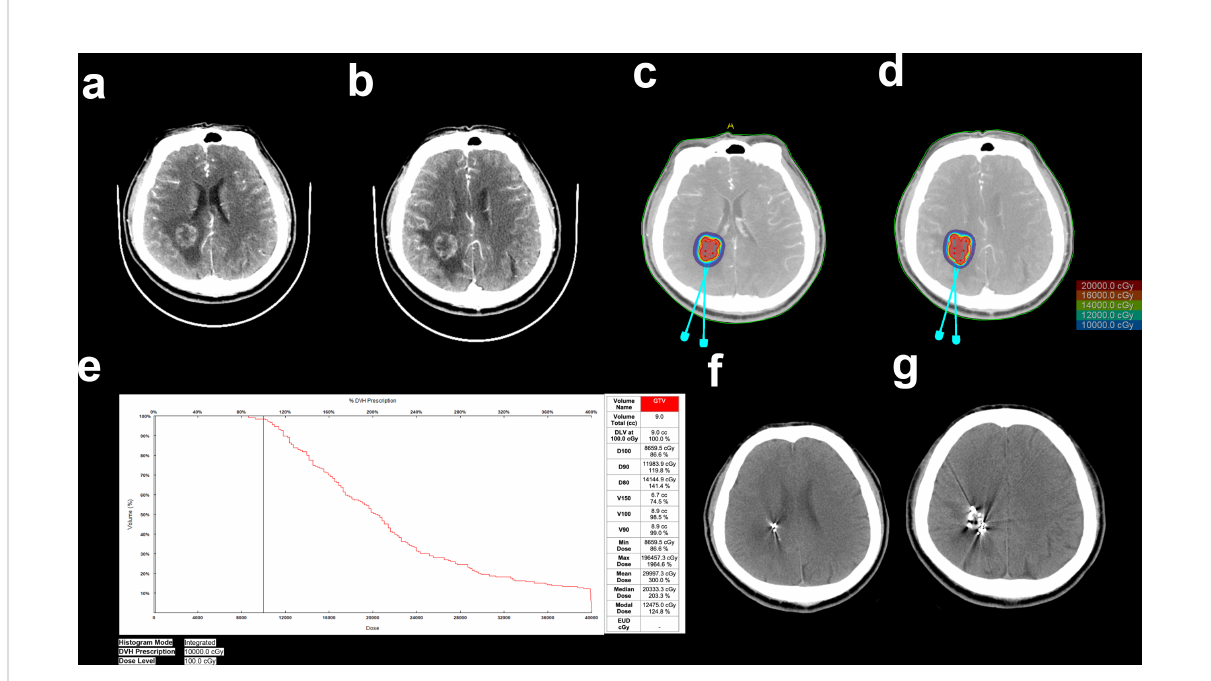
FIGURE 1 Implantation of 125 I seeds with the guidance of TPS. (A, B) Enhanced CT images of BMs resulting from NSCLC. (C, D) Needle paths were designed with TPS. (E) Preimplantation dose volume histogram (DVH) of GTV. (F, G) CT images of the brain after 125 I seed